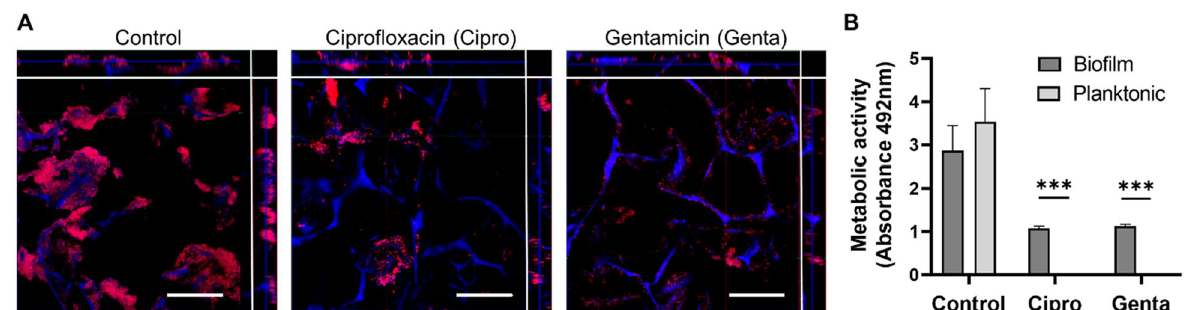
Figure 4. Broad-spectrum antibiotics treatment of biofilms formed in the scaffolds. ( A ) Biofilm-containing scaffolds treated with antibiotics were fixed and stained with PI (red) and DAPI (blue) for confocal microscopy visualization, showing remaining biofilms. Side images from left panels represent a Z-view of two optical sections (X- and Y-view) from the scaffold. ( B ) Viability assay (XTT) of biofilms formed over scaffolds and treated with antibiotic confirms a significantly higher metabolic activity compared to planktonic cultures. Scale bar represent 50 µm in A. Values plotted are mean ± SD (N = 3). Two-way ANOVA and Sidak’s multiple comparisons test. ***p < 0.0001. In A, blue signal is present in all groups due to collagen